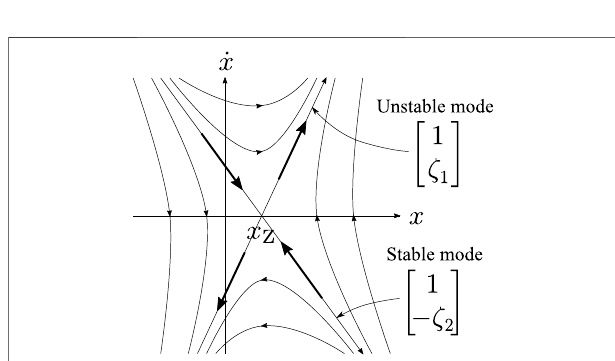
≡ const. It has Z FIGURE 11 | phase portrait of the system Eq. 12 with x two eigenvalues ζ 1 (unstable) and − ζ 2 (stable) with asymmetric asymptotic directions [ 1 ζ 1 ] T and [ 1 − ζ 2 ] T